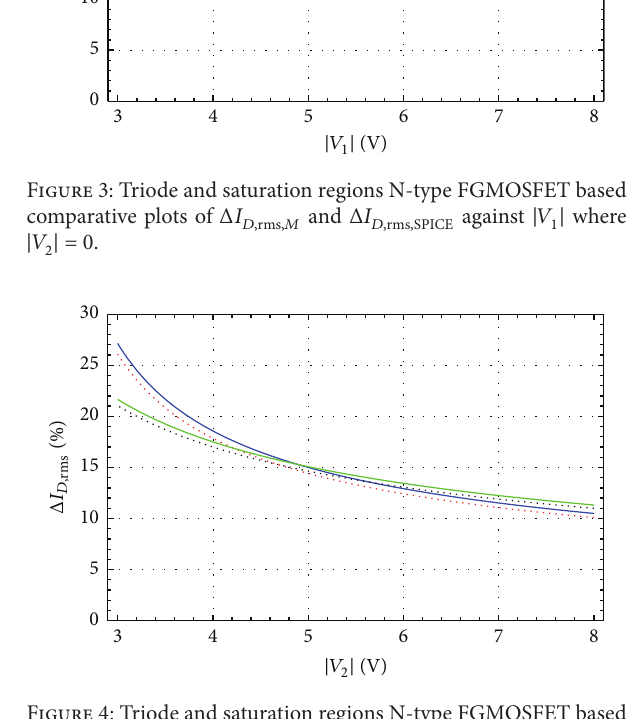
Figure 4: Triode and saturation regions N-type FGMOSFET based comparative plots of Δ𝐼 𝐷, rms ,𝑀 and Δ𝐼 𝐷, rms , SPICE against |𝑉 2 | where | = |𝑉 1